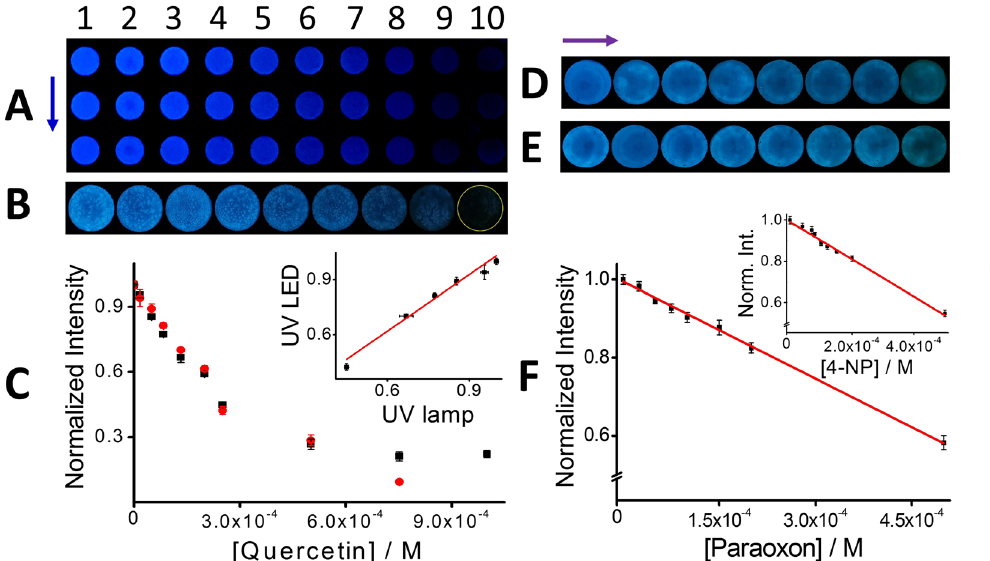
Figure 4. Performance of the LED-based device compared to the UV light readouts. Fluorescence quenching of GQDs with increasing concentrations of quercetin observed under the UV light ( A ); and with the LED device ( B ), respectively. Concentrations are 0 (0.01 M PBS Buffer), 1.66 × 10 − 5 , 4.98 × 10 − 5 , 8.30 × 10 − 5 , 1.33 × 10 − 4 , 1.99 × 10 − 4 , 2.51 × 10 − 4 , 5.01 × 10 − 4 , 7.52 × 10 − 4 , 1.25 × 10 − 3 , 1.50 × 10 − 3 M, from 1 to 10, respectively. Three replicates of the same concentrations are denoted by the blue arrow. Graphics of estimated fluorescence of the spots with increasing concentration of quercetin observed under the UV lamp (black dots); and with the LED device (red dots) ( C ). Inset is the correlation of the two methods. Decreasing concentrations of 4-nitrophenol (4-NP) ( D ) and paraoxon ( E ) ranging from 0 to 5 × 10 − 4 M are denoted by the purple arrow. The corresponding Stern–Volmer relationship for paraoxon ( F ) and 4-NP